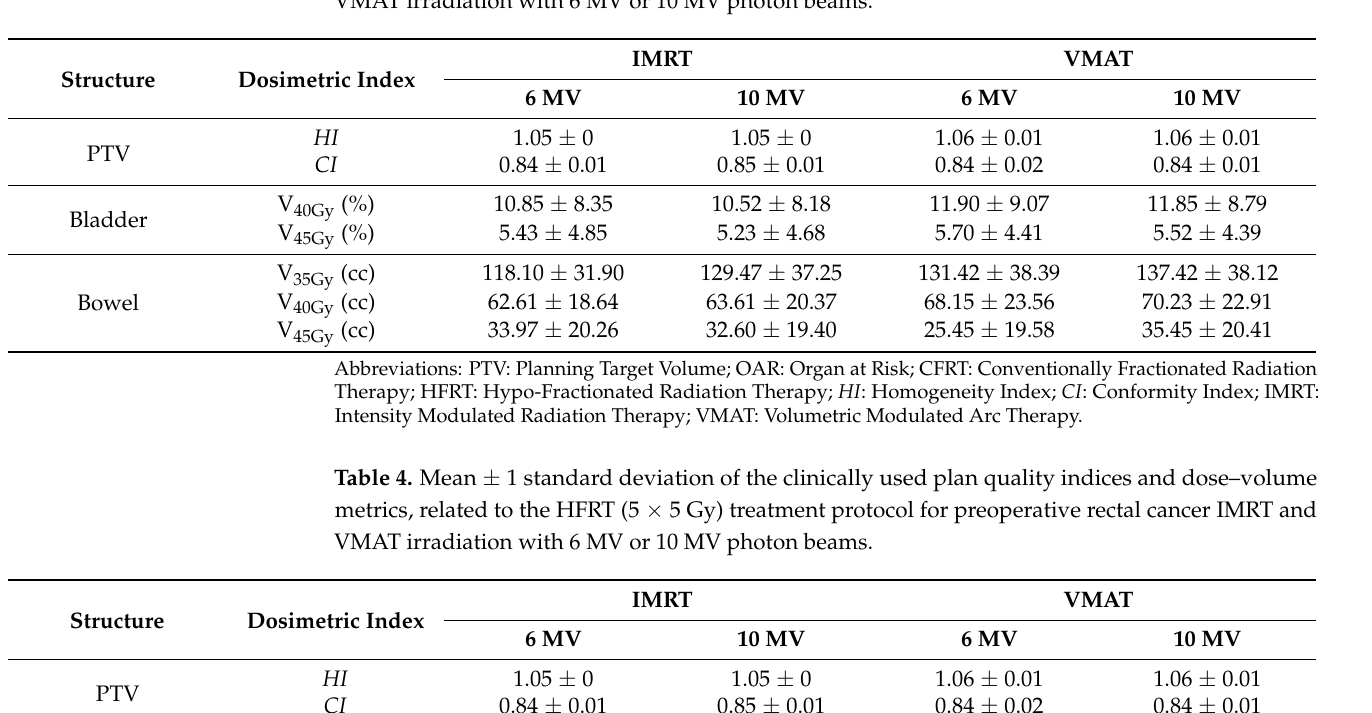
Table 3. Mean ± 1 standard deviation of the clinically used plan quality indices and dose–volume metrics, related to the CFRT (25 × 2 Gy) treatment protocol for preoperative rectal cancer IMRT and VMAT irradiation with 6 MV or 10 MV photon beams.